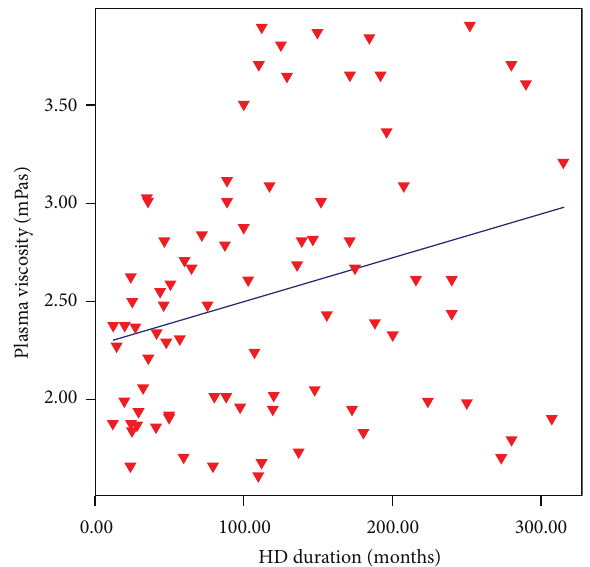
Figure 1: Plasma viscosity was positively correlated with patients’ hemodialysis duration ( 𝑟 : 0.287, 𝑃 :